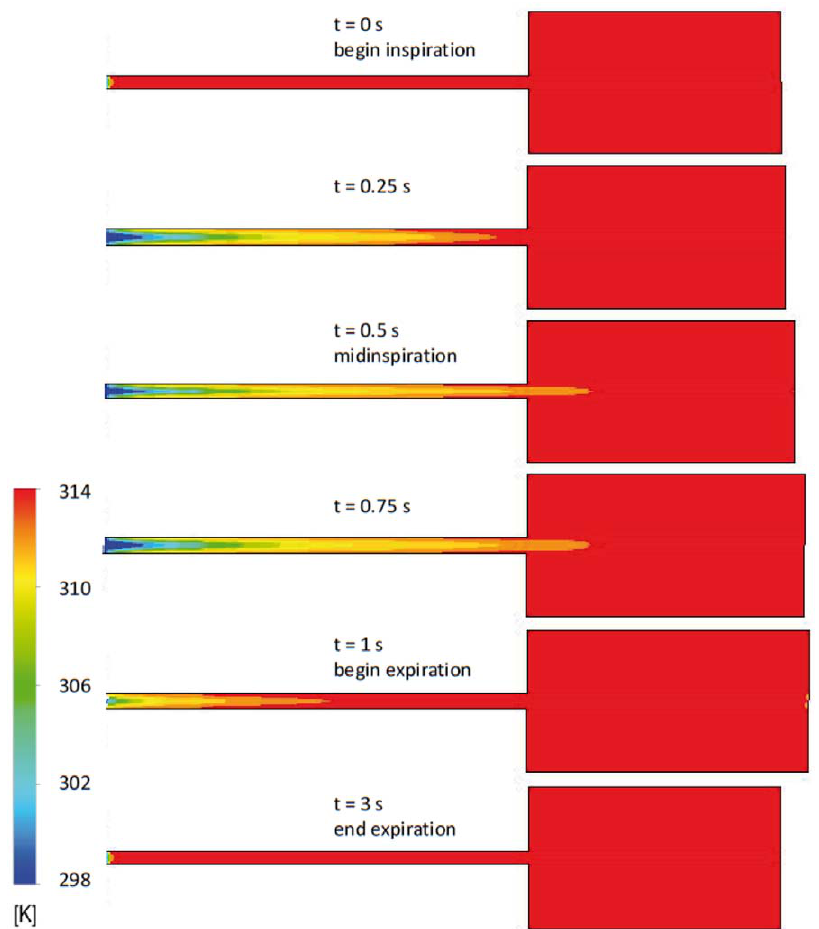
Figure 5. Temperature distribution in the 2D model during the breathing cycle. The maximal volume increase is seen at 1 s at the end of inspiration/begin of expiration, the initial air sac volume is reached at 3 s, end expiration. doi:10.1371/journal.pone.0045315.g005 the anterior and posterior tracheal regions. The resulting finest vessels come to lie immediately beneath the epithelial cells.